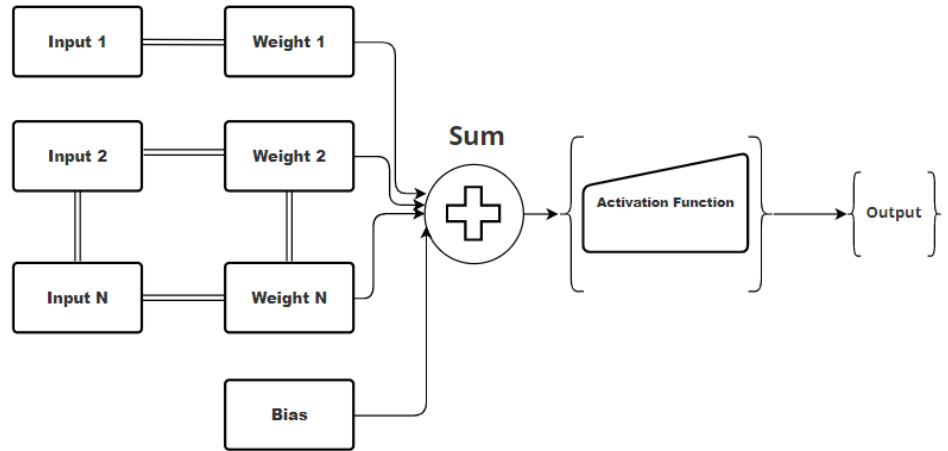
Figure 3. Working principle of artificial neuron.